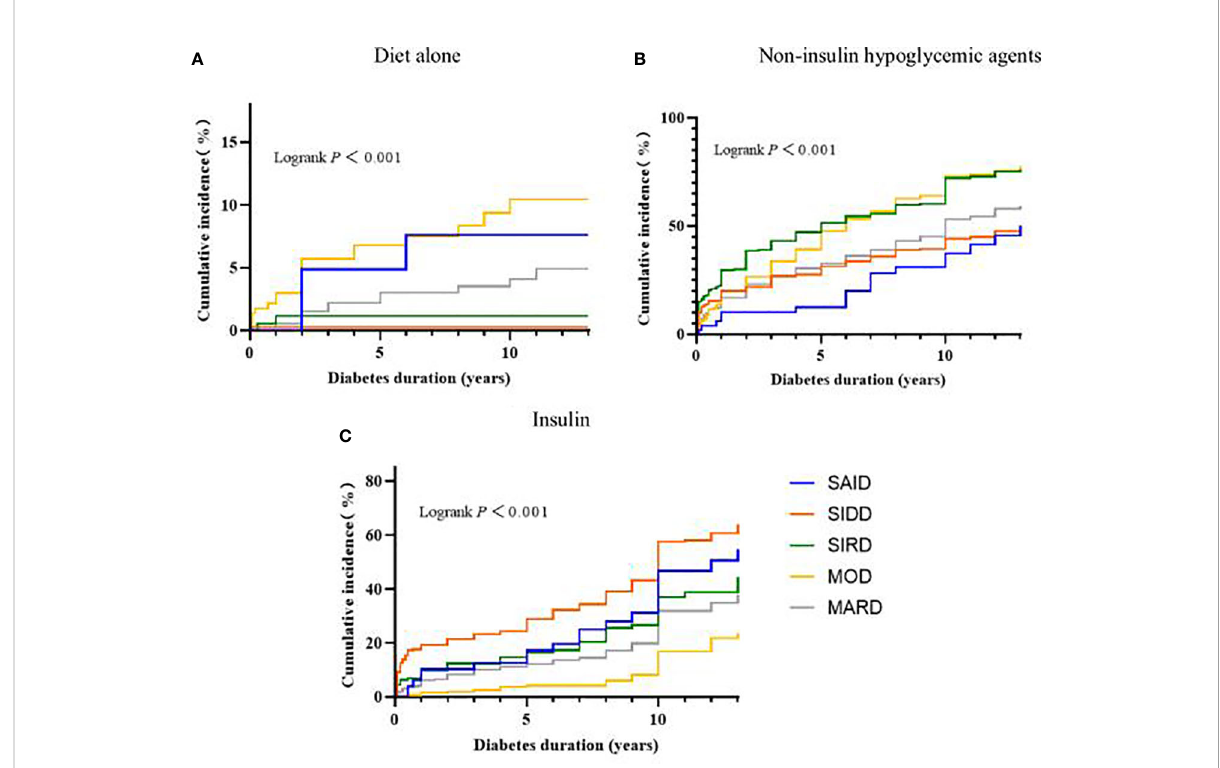
FIGURE 3 Progress in the treatment of diabetes between subgroups. Kaplan-Meier curves for the development of (A) Diet alone, (B) Non-insulin hypoglycemic agents, (C) Insulin. SAID, severe autoimmune diabetes; SIDD, severe insulin-de fi cient diabetes; SIRD, severe insulin-resistant diabetes; MOD, mild obesity-related diabetes; MARD, mild age-related